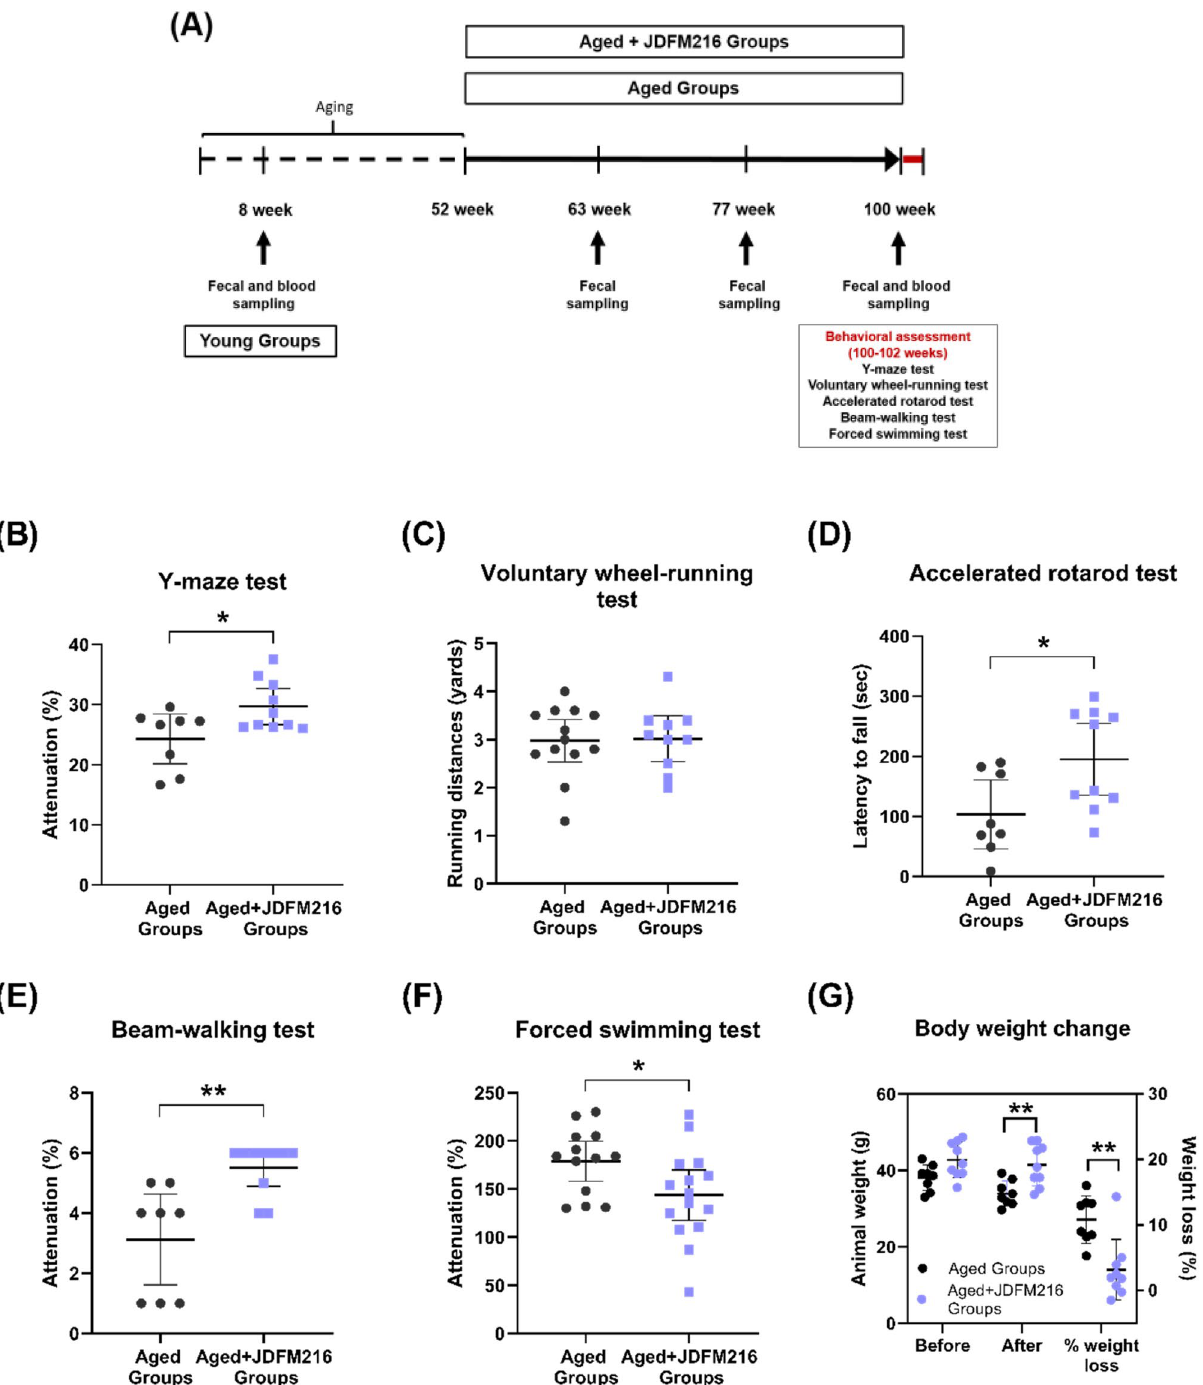
Figure 1. Behavioral assessments of JDFM216-treated aged mice. ( A ) Representation of the study design. JDFM216 or vehicle (sterile water) was administered for a total period of 48 weeks to C57BL/6 mice. ( B ) Y-maze test. ( C ) Voluntary wheel-running test. ( D ) Accelerated rotarod test. ( E ) Beam-walking test. ( F ) Forced swimming test (FST). ( G ) The average weight and % weight loss of aged mice before and after the battery of behavioral tests (100 and 102 weeks). For all graphs, data are expressed as the means ± SD. n = 13–15 per group. Levels of significance determined by the Student’s t test are as follows: * P < 0.05; ** P < 0.01; *** P < 0.001, compared with the aged mouse